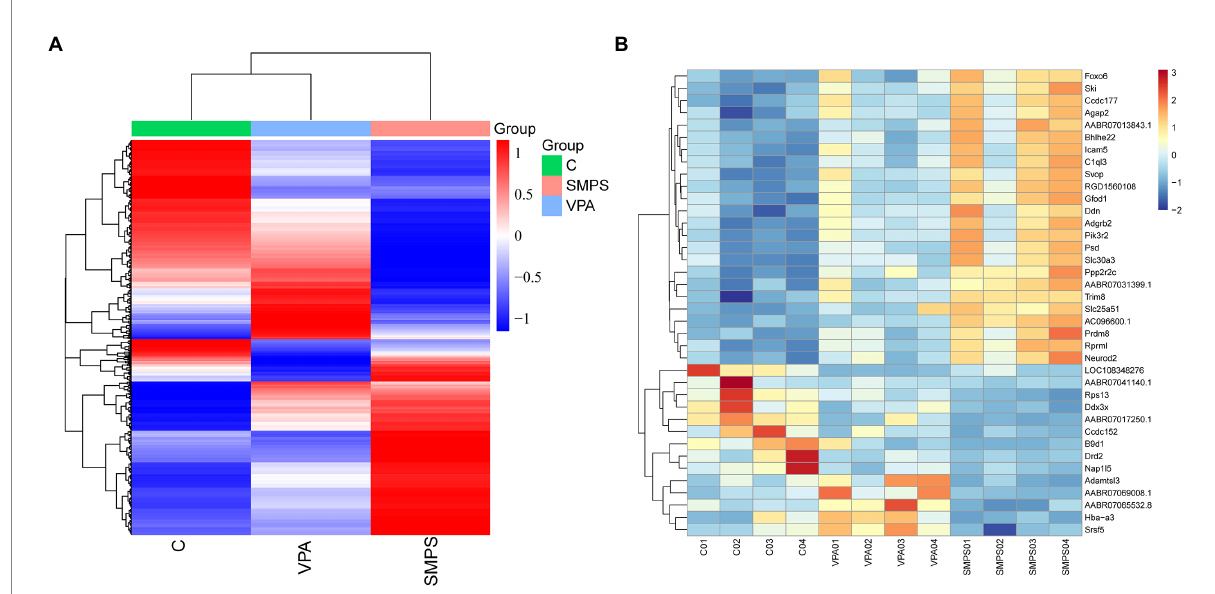
FIGURE 6 Cluster heatmaps among the SMPS, VPA and C groups ( n = 4 per group). (A) Hierarchical clustering heatmap of DEGs among the three groups; (B) Clustering heatmap showed 38 common DEGs among the three